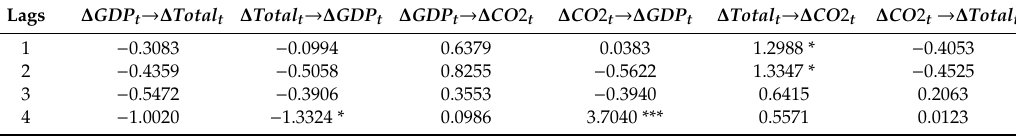
Table 10. Bivariate Nonlinear Granger Causality Test.